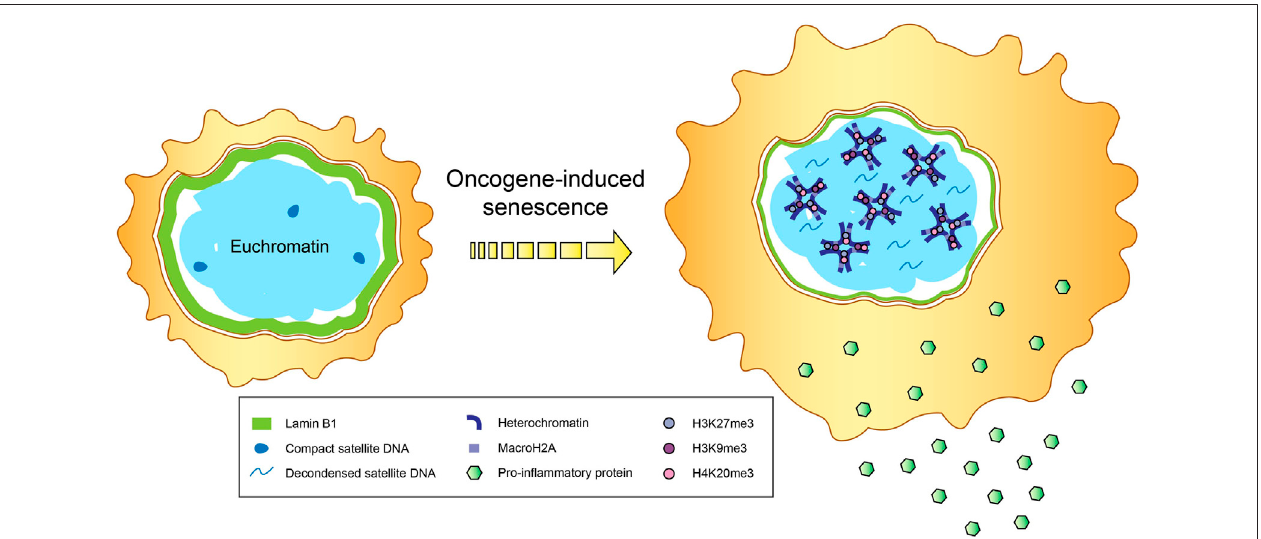
FIGURE 1 | Epigenetic changes in senescence. Secretion of proin fl ammatory cytokines and immunomodulatory proteins that constitute the senescence- associated secretory phenotype (SASP), accompanied by the formation of senescence-associated heterochromatin domains (SAHDs) and compact senescence- associated heterochromatic foci (SAHF), occur in cells undergoing oncogene-induced senescence (OIS). In addition to the enrichment of repressive histone modi fi cations (e.g., trimethylationofH3K9, H3K27 and H4K20) and the histonevariant macroH2Awithin SAHFs, OIS-induced cells also tend toexhibitareduction in lamin B1 levels and decondensation of satellite DNA, in a process called senescence-associated distension of satellites (SADS).